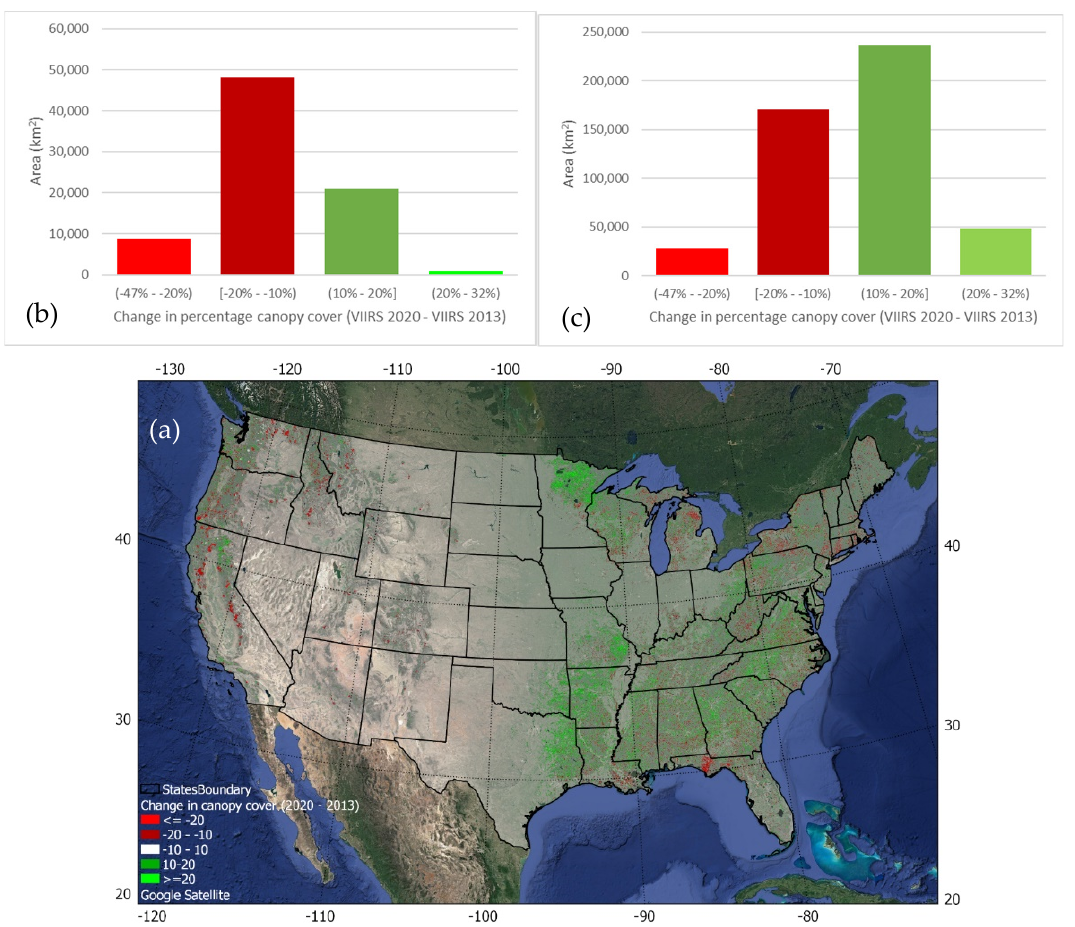
Figure 11. ( a ) Changes in percentage tree cover from 2013 to 2020 (VIIRS 2020 − VIIRS 2019) for the conterminous US. Over the period of 8 years, some 56,000 km 2 of western forests (west of − 100 ◦ parallel) lost more than 10% of their tree cover while only 22,000 km 2 of forests increased their cover density by 10% or more ( b ). To the east, the area of forests with gains in canopy cover of 10% or more exceeded 285,000 km 2 compared to 199,000 km 2 of forests that lost 10 or more of their canopy cover ( c